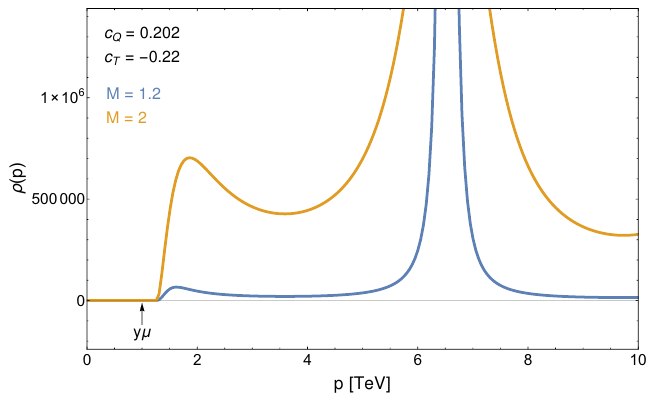
Figure 14 . The e(cid:11)ect of the IR mass on the width of a fermionic peak in a toy model with a single bulk fermion. By varying the IR mass, the peak could be made as wide as 2 TeV.